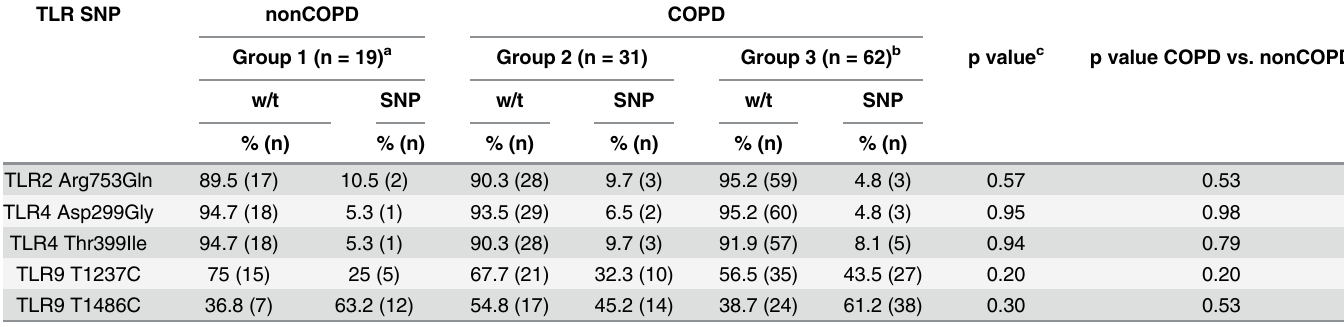
Table 5. Frequency of TLR polymorphisms. Frequency is shown of each TLR polymorphism (SNP) compared with wildtype (w/t) among each group of bronchoscopy participants. Statistical comparisons are as indicated in Table 4. TLR